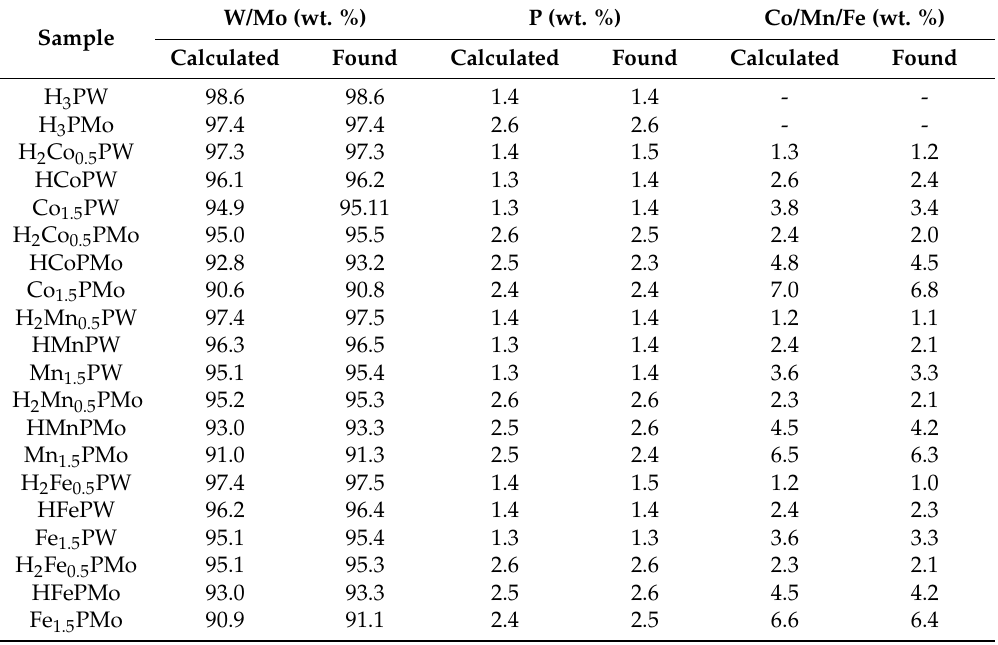
Table 1. Content of key elements in the investigated heteroply compounds determined by X-ray fluorescence